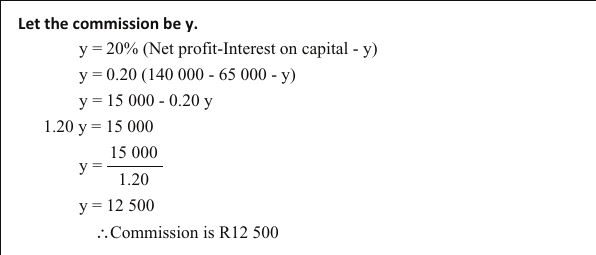
FIGURE 13: Commission calculation using linear equation method.